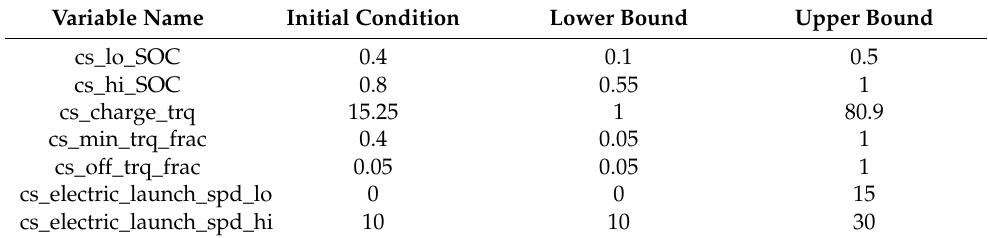
Table 2. Design variable parameters.